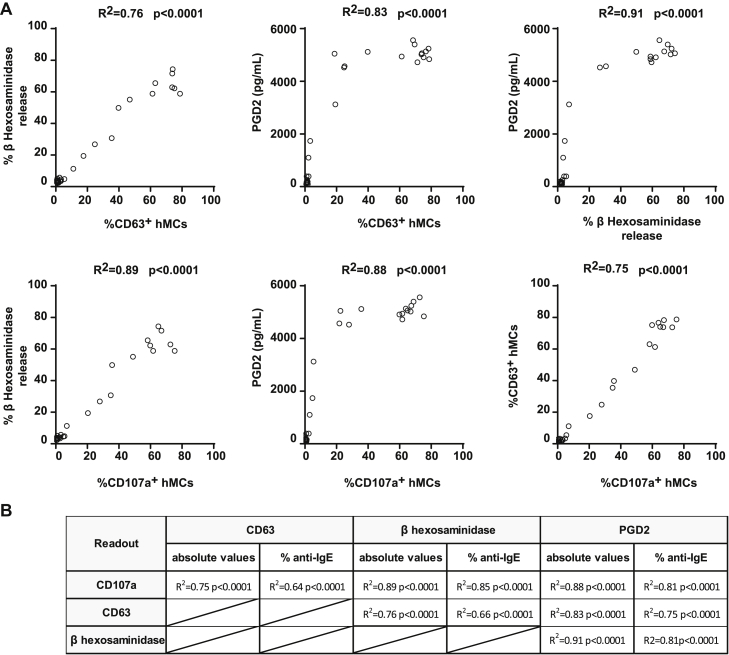
Correlation of surface expression and mediators release measurement. hMCs were sensitized overnight with serum from patients with peanut allergy, patients with grass pollen allergy, or both (volume ratio, 1:10); washed; and either left untreated or exposed for 1 hour to different concentrations of peanut or grass pollen extract or anti-IgE (10 μg/mL) as a positive control. hMC degranulation was measured by CD63 and CD107a surface staining and analyzed by using flow cytometry. β-Hexosaminidase levels were measured in cell pellets, as well as in supernatants, and expressed as percentage β-hexosaminidase release. PGD2 levels were measured in supernatants. The assay was performed in duplicates or triplicates with pooled hMCs from at least 3 different healthy donors. Correlations were calculated by using Spearman R (R2) values (A) with both absolute values and percentages of readout induced by anti-IgE summarized in B.